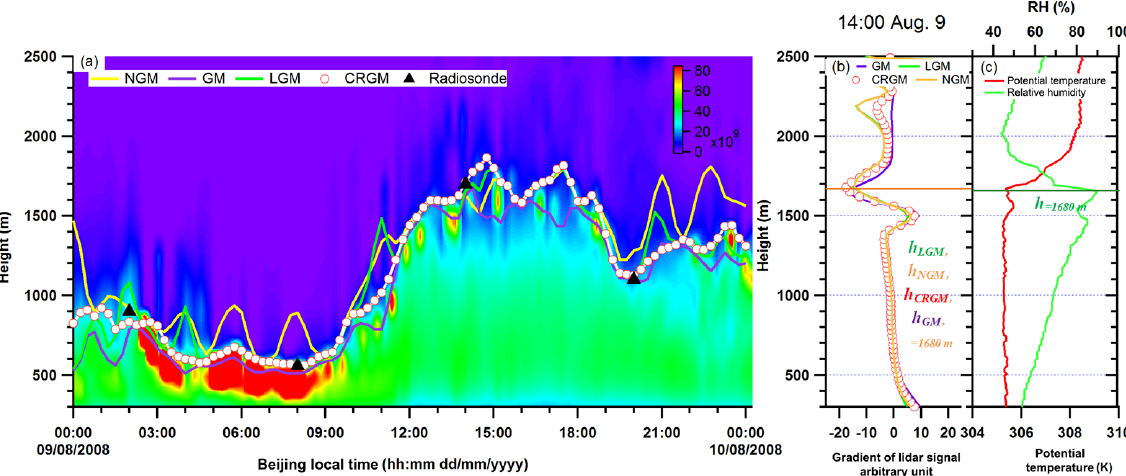
Figure 6. (a) Same as Fig. 4a but for 9 August. (b) Same as Fig. 4b but for 14:00 on 9 August. (c) Same as Fig. 4c but for 14:00 on 9 August.